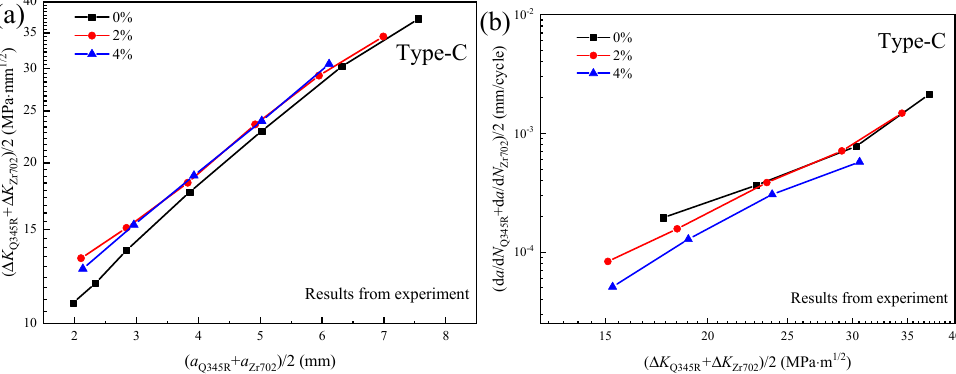
Figure 12. Effect of pre-strain on overall performance of the through-wall crack: ( a ) a -d a /d N , ( b ) Δ K -d a /d N.